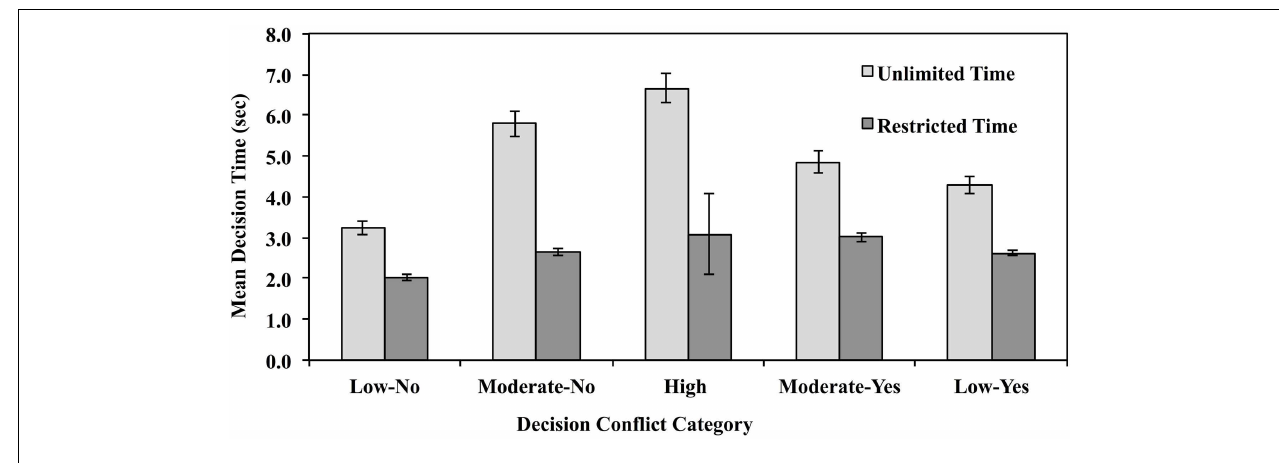
FIGURE 2 | Mean decision time for decisions made under unlimited- and reduced-decision time for high-conflict vignettes (long decision times and low decision consensus), moderate conflict vignettes (moderate